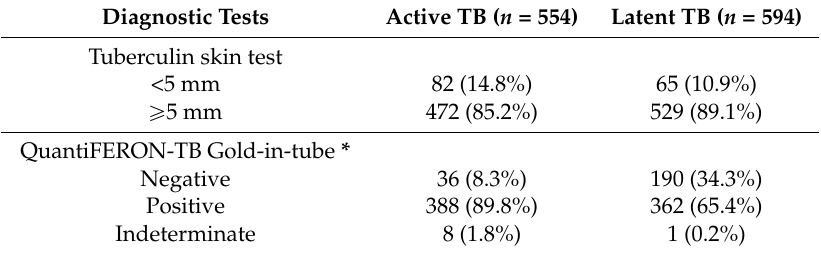
Table 4. Tuberculin skin test and QuantiFERON-TB Gold-in-tube (QFT-IT) results according to tuberculosis (TB)